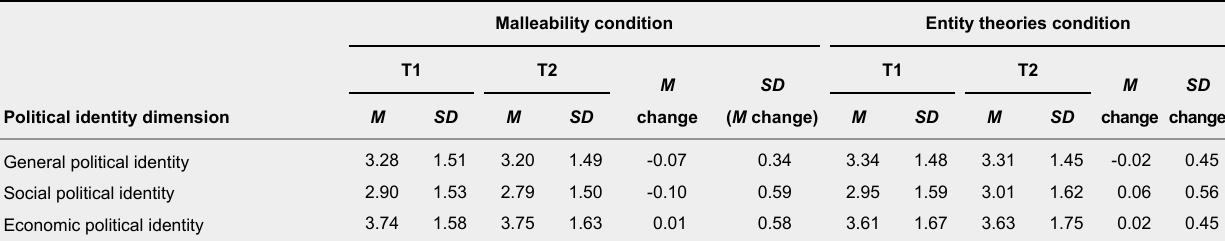
Means, SDs and Mean Change at T1 and T2 in the Different Experimental Conditions Political identity dimension